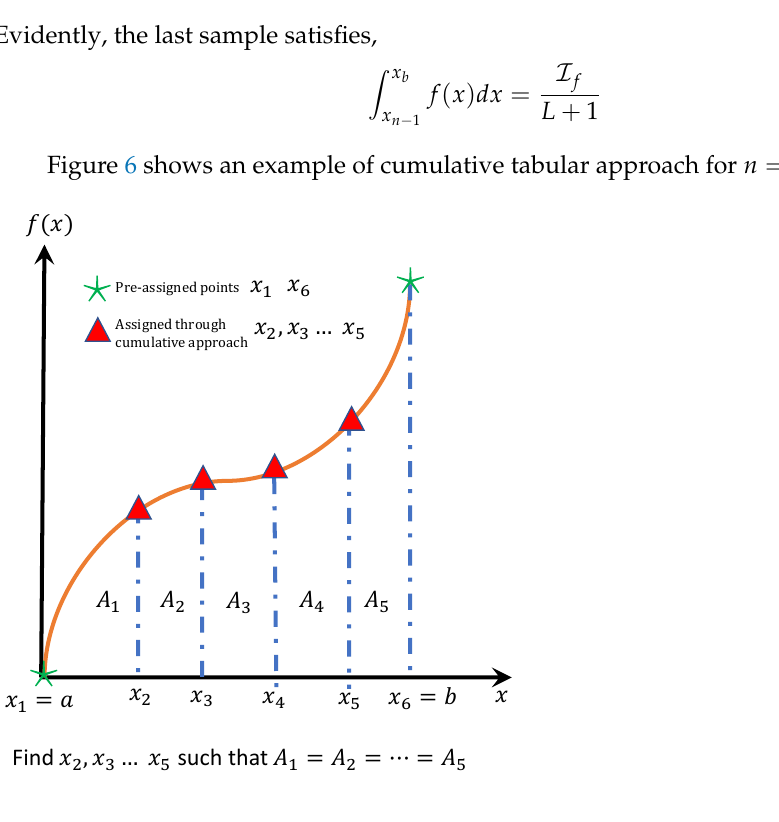
Figure 6. Pictorial representation of cumulative approach for n = 6